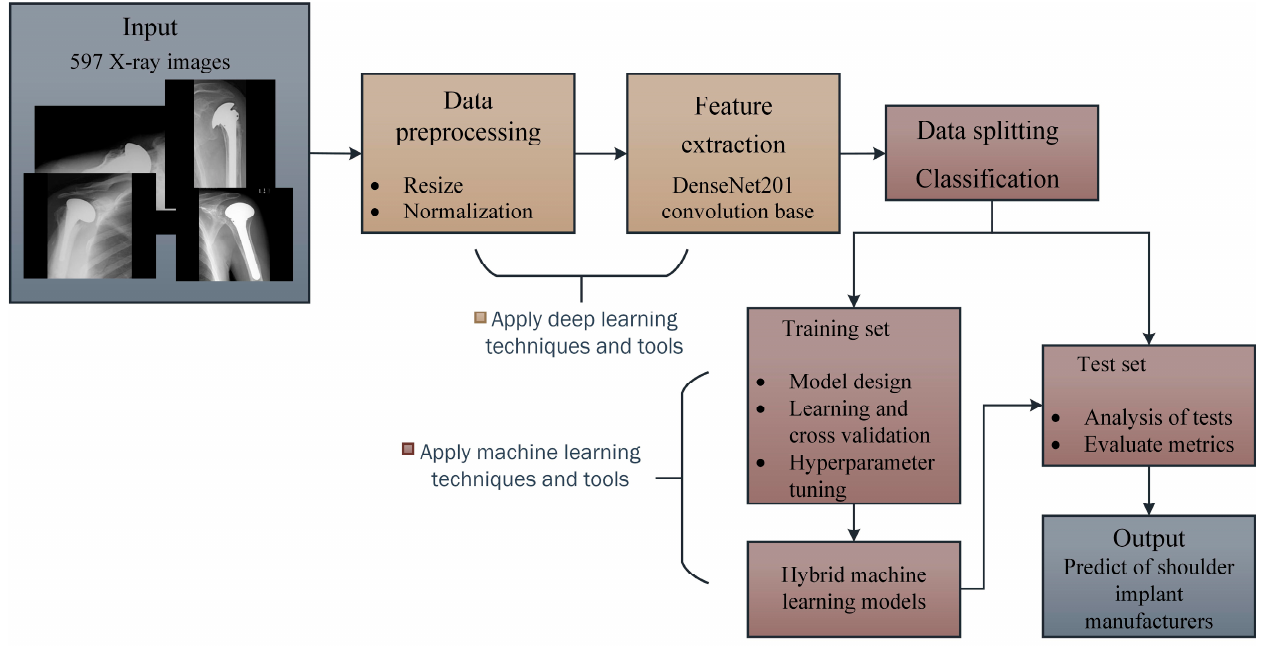
Figure 2. Overview of the proposed method.